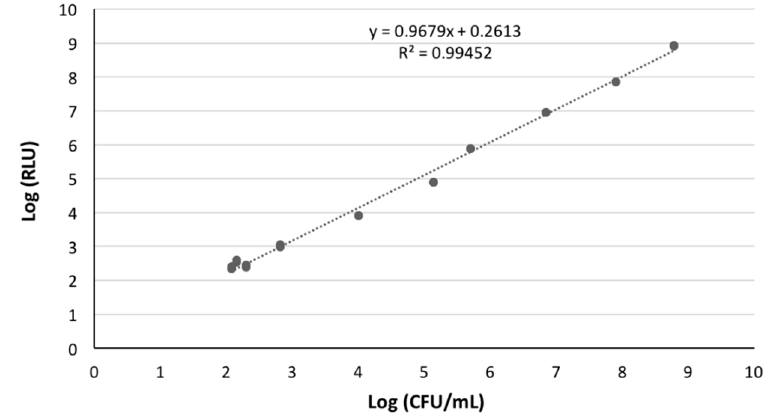
Figure 2. Association between the bioluminescence signal and viable counts of an overnight culture of a transformed bioluminescent E. coli . Bioluminescence is expressed in RLUs and viable counts in CFU/mL.